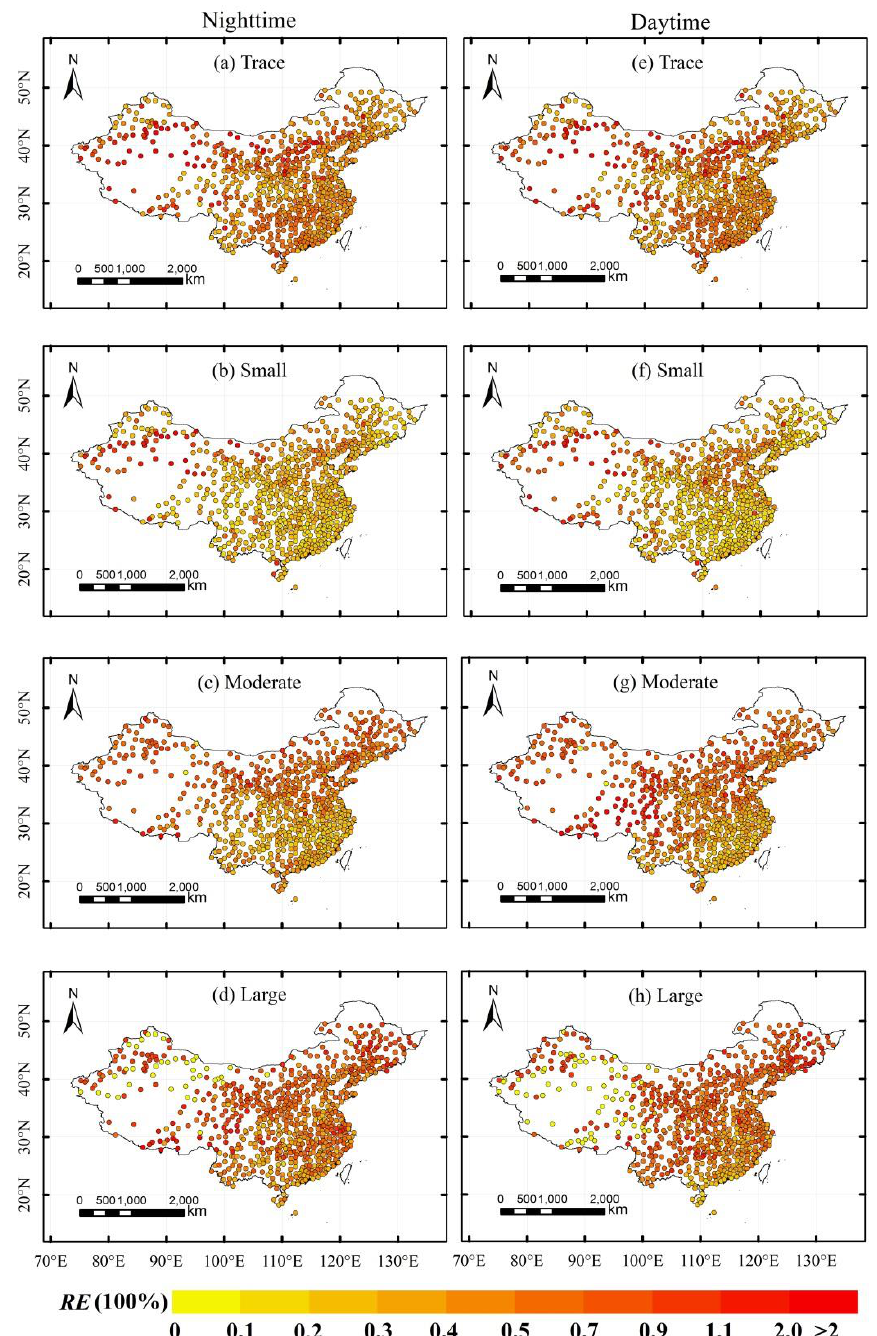
Figure 13. As in Figure 11, but for the amount of precipitation.